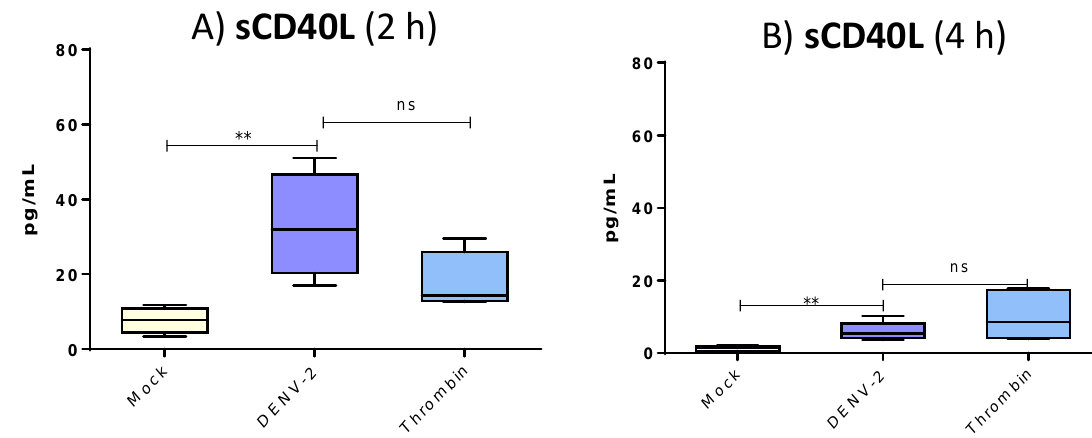
Figure 5. Human platelets release sCD40L after DENV stimulus. In supernatants of 3 × 10 8 /mL treated platelets from healthy donors ( n = 15), soluble CD40L was measured by ELISA test. At 2 and 4 h, platelets were DENV-2 stimulated, MOI 0.2, at 37 ◦ C. Optical density was read at 450 nm and amount of sCD40L calculated for each experimental group. Unpaired t test was used, ** p < 0.01 and ns = not